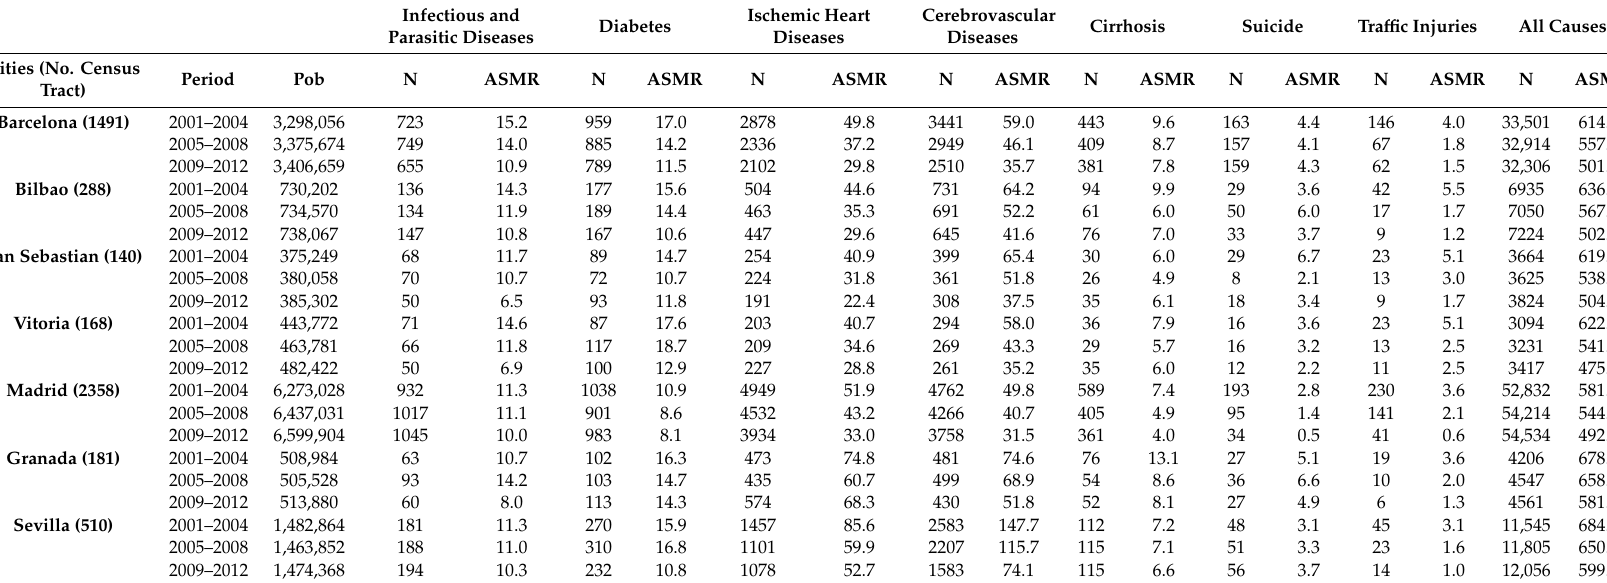
Table 2. Population, number of deaths (N), and age-standardized mortality rate (ASMR) per 100,000 inhabitants by period and cause of death in 7 Spanish cities for women, 2001–2012.